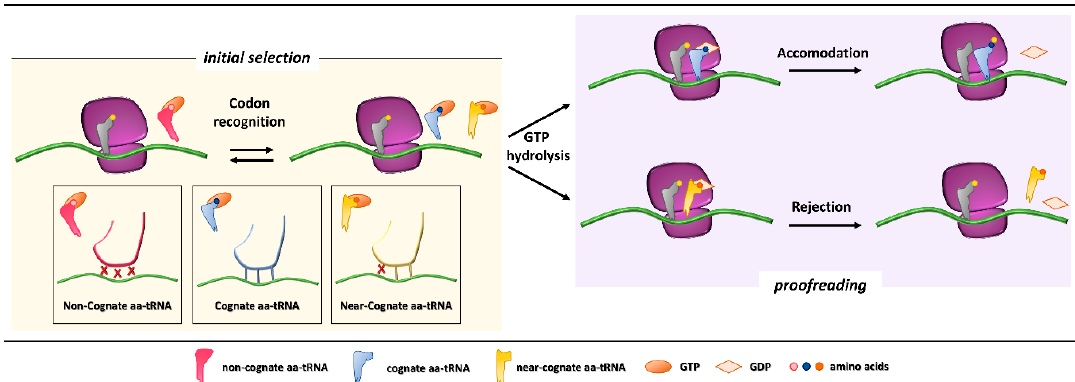
Figure 1. Initial selection and proofreading activity of the translating ribosome. The insertion of cognate or near-cognate, as well as the rejection of non-cognate, aa-tRNAs is exerted by the ribosome during the initial selection step ( left panel , with codon-anticodon interactions depicted in the boxes below). Upon GTP hydrolysis, the cognate aa-tRNA is e ffi ciently accommodated, with formation of peptide bond and progression of protein synthesis with a new aa-tRNA selection step ( right panel , upper part ). The presence of a near-cognate aa-tRNA, which fails to be accommodated, results in rejection of the aa-tRNA through a proofreading step ( right panel , lower part ).